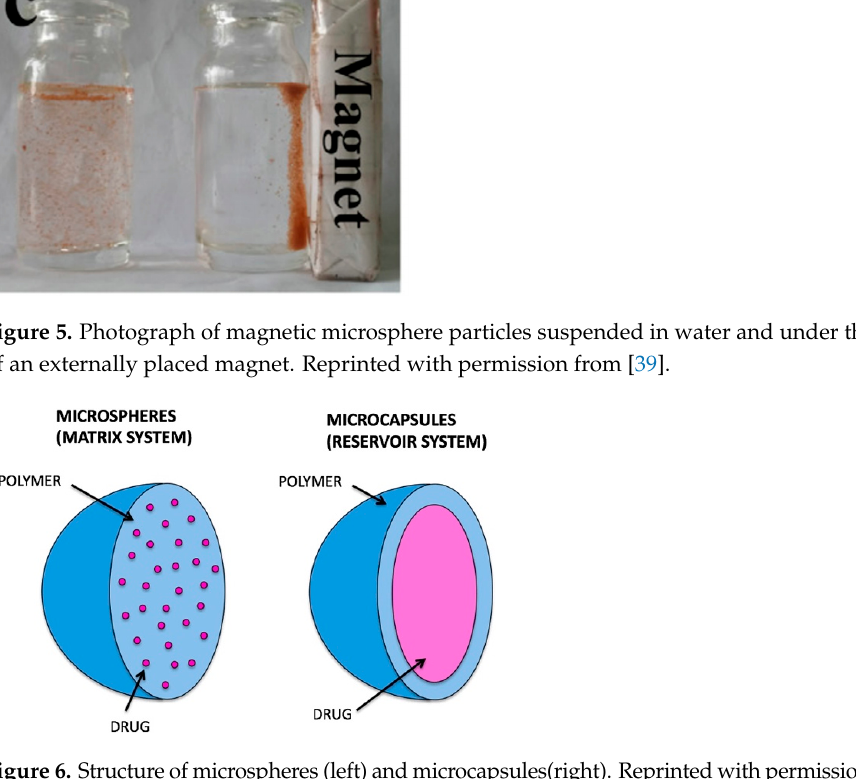
Figure 6. Structure of microspheres (left) and microcapsules(right). Reprinted with permission from